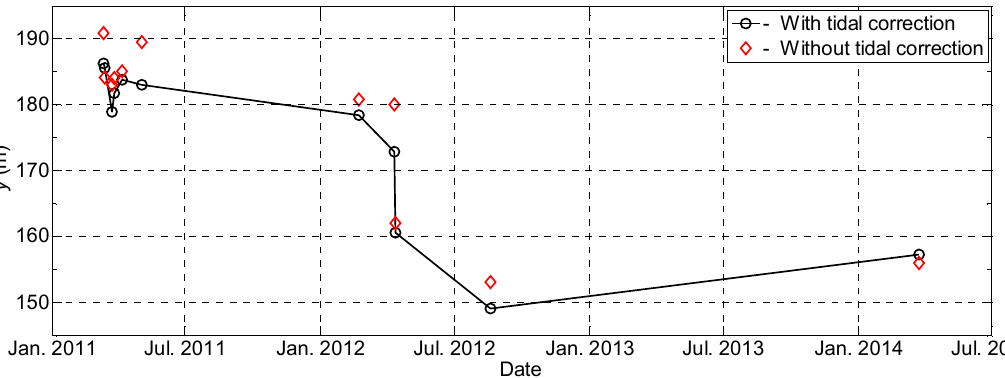
Figure 7. Temporal variation of extracted shoreline position in cases without and with tidal correction.